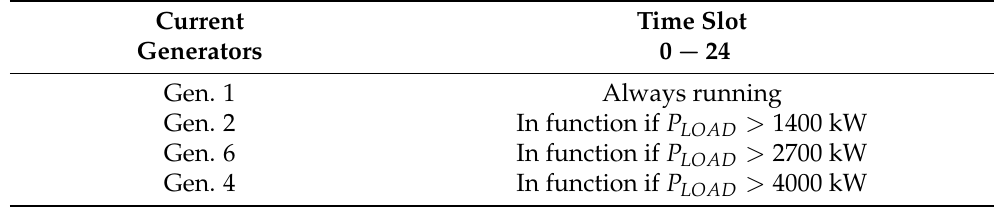
Table 15. Control logic of diesel groups in the rest of the